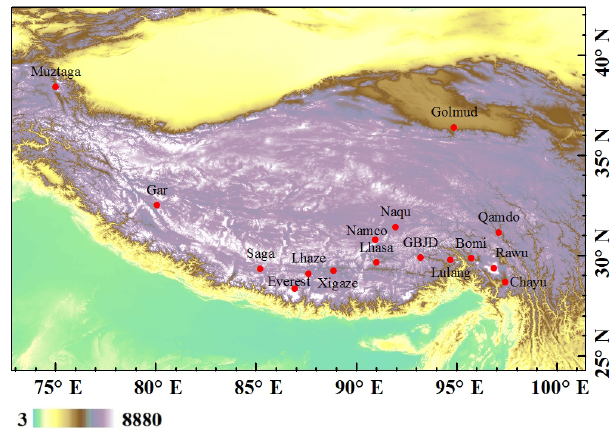
Figure 1. Map showing the sampling sites of the POP monitoring programme across the Tibetan Plateau. The values in the legend are in